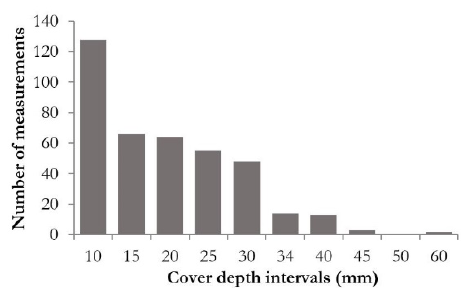
Figure 5. Distribution of cover depth measured on the façades of the Artigas building.